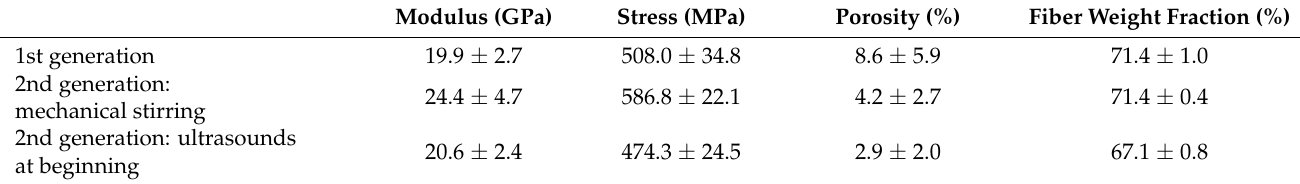
Table 3. Modulus, tensile strength, and porosity of first and second generation Elium ® /basalt composites recycled using mechanical stirring and ultrasounds at the beginning of the dissolution. Modulus (GPa) Stress (MPa) Porosity (%) Fiber Weight Fraction (%) 19.9 ± 2.7